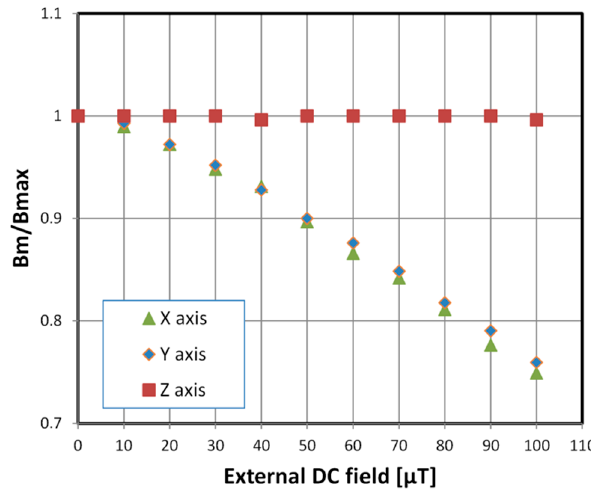
Figure 4. Dependence of measured maximal induction B m value on the external homogeneous field. Values normalized with a B max for an external field equal 0 ± 0.01 μ T in all three axes. Each of the axes were investigated separately. The obtained values for fields in the plane of the ring sample (X and Y) are similar while the influence of the transverse field (Z axis, along the axis of the ring core) is negligible.